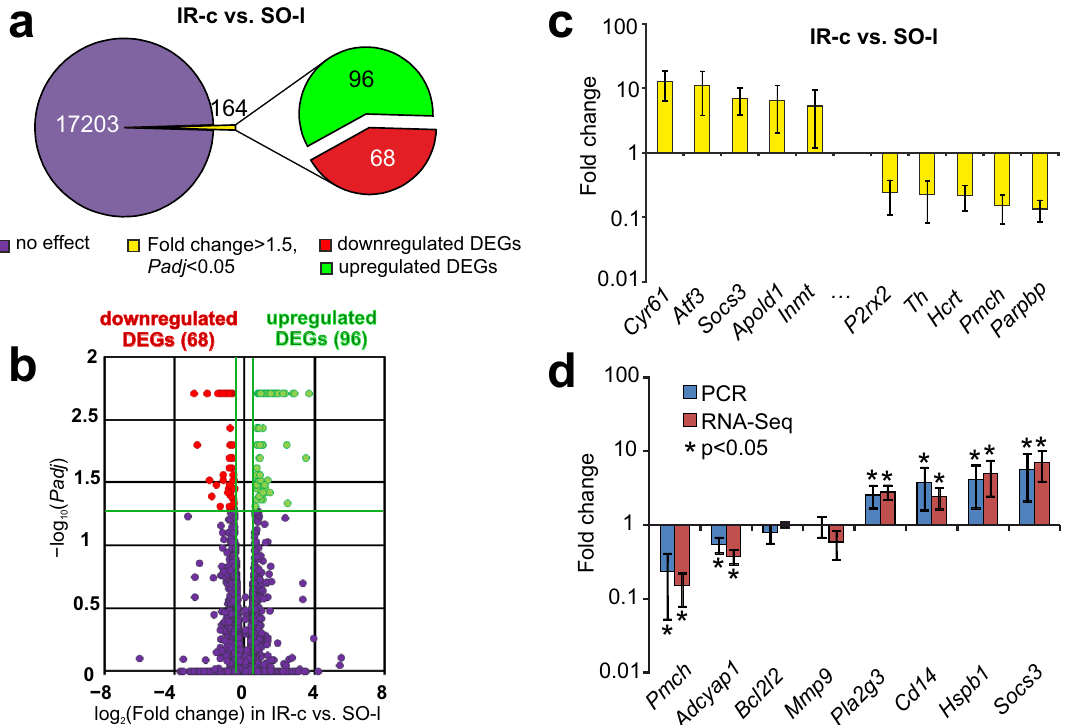
Figure 1. RNA-Seq analysis of DEGs at 24 h after tMCAO in subcortical structures of the CH related to the corresponding brain samples from SO rats. ( a ) RNA-Seq results for IR-c versus SO-l. The numbers in the diagram sectors indicate the number of DEGs. ( b ) A volcano plot shows a comparison of the distribution of genes between the IR-c and SO-l groups. Upregulated and downregulated DEGs are represented as red and green dots, respectively (fold change > 1.50. Padj < 0.05). Not differentially expressed genes (non-DEGs) are represented as dark purple dots (fold change ≤ 1.50. Padj ≥ 0.05). ( c ) The top 10 genes that exhibited the greatest fold change in expression in IR-c vs. SO-l. The data are presented as the mean ± standard error (SE) of the mean. ( d ) RT–PCR verification of the RNA-Seq results. Data for the comparison between IR-c and SO-l are shown. Two reference mRNAs Gapdh and Rpl3 were used to normalize the PCR results. Each group included at least five rats. Six genes whose expression changed by > 1.5-fold from the baseline value and whose P -value was < 0.05 and two other genes were selected for analysis. The data are presented as the mean ±